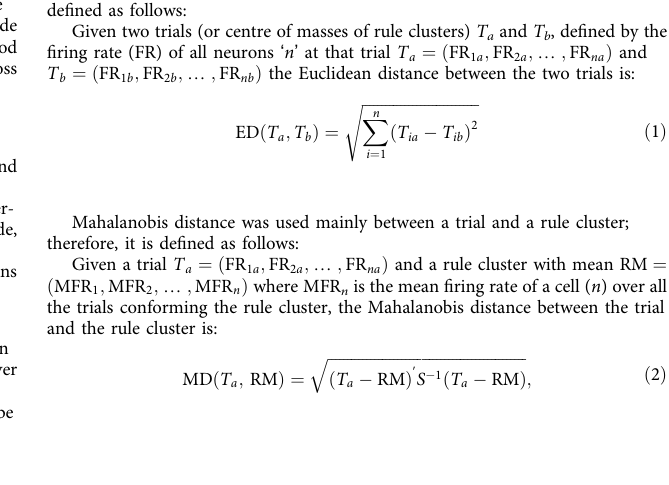
Fig. 6 Trajectory and speed of the animal do not explain the different neuronal network representation of rules and its repetitions. a Overlapping running- trajectories during a rule and during the later repetition of the same rule. b Trajectory during one trial (black) and the fi tted parabola (red). c Different trajectories in the same recording day and their fi ttings. d Right, similarity index distributions calculated for all possible pairs between trajectories during trials within a rule ‘ A ’ (top) and the possible pairs between trajectories during a rule ‘ A ’ and its repetition ‘ A° ’ (bottom). Green denotes similar ( < 5 percentile) and different ( > 95 percentile) pairs. Left, comparison of the Euclidean distance in the network fi ring state for trials with similar trajectories between a rule ‘ A ’ and its repetition ‘ A° ’ and for trials with different trajectories belonging only to rule ‘ A ’ ( p = 0.0017, Wilcoxon rank-sum test). Box plots show median, 25th and 75th percentile. e After removing the effect of the trajectory and the speed of the animal, residuals remain correlated to performance, similar to neuronal fi ring rates ( n = 300, p < 1e − 20, r = 0.9123, Spearman correlation). f Same as ( e ) but for fi ring rates of